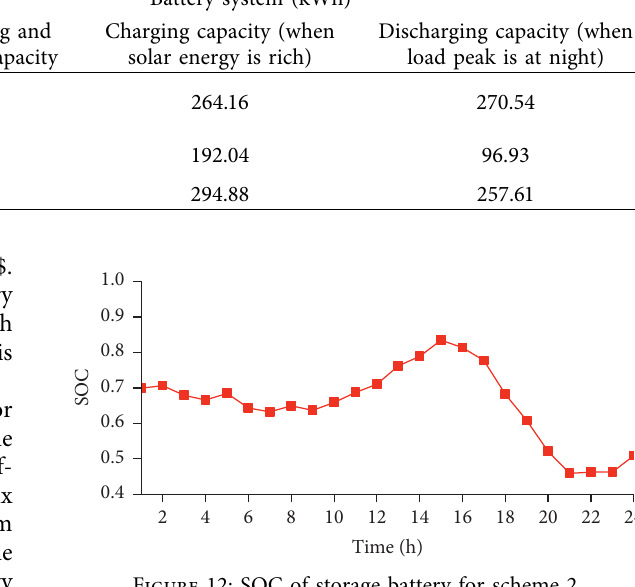
Table 11: The daily power generation of diesel generator and charging and discharging capacity of battery system. Scheme